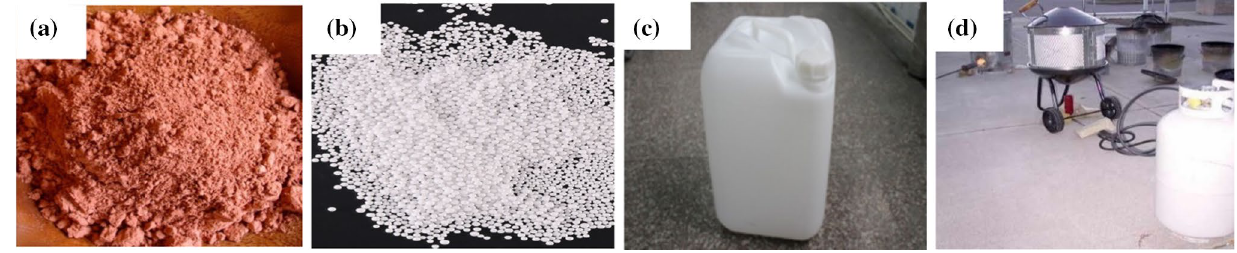
Fig. 7 The raw ingredients used in manufacturing the ceramic cylinders: a red clay powder, b foam balls (1–3 mm), c water, d very simple